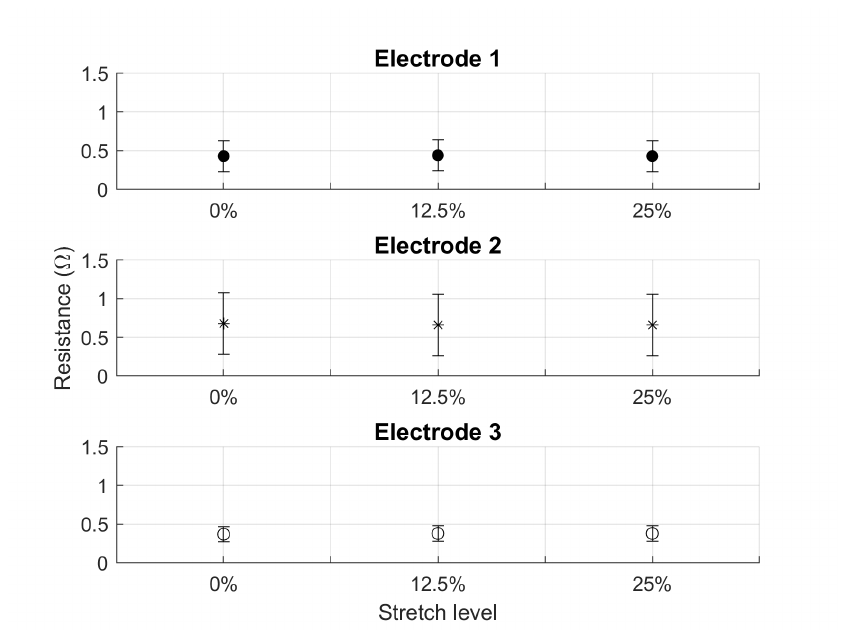
Figure 4. Stretch testing results for each of the three electrodes with error bars representing one standard deviation. Resistance change between stretch levels for all three electrodes is within the standard deviation of the three measurements taken, so there is no observable change.